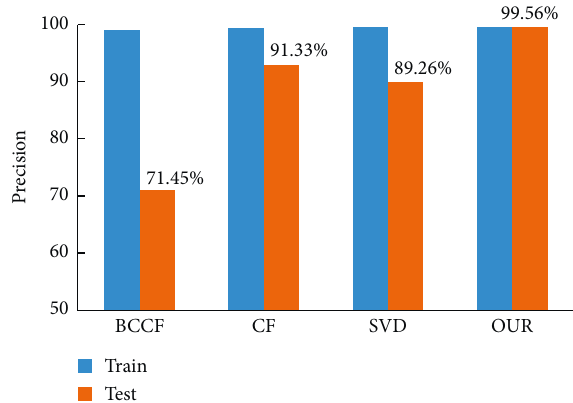
Figure 5: Comparison of precision on MovieLens latest with N �